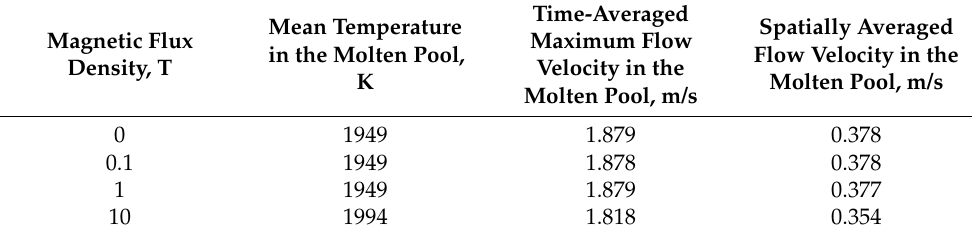
Table 2. Cumulative results of a series of numerical simulations at different levels of the magnetic flux density B z = 0, 0.1, 1 and 10 T. The temperature and flow characteristics are averaged in the molten pool. Time-Averaged Spatially Averaged Mean Temperature Maximum Flow Magnetic Flux Flow Velocity in the in the Molten Pool, Velocity in the Density, T Molten Pool, m/s K Molten Pool, m/s 0 1949 1.879 0.378 0.1 1949 1.878 0.378 1 1949 1.879 0.377 1994 1.818 0.354 16 of 19